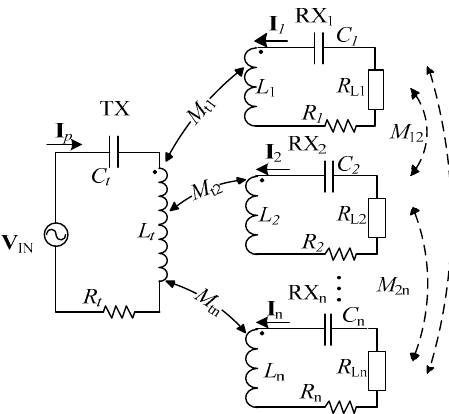
Figure 1. An equivalent circuit for a multi-load wireless power transfer (WPT) system based on S–S compensation.